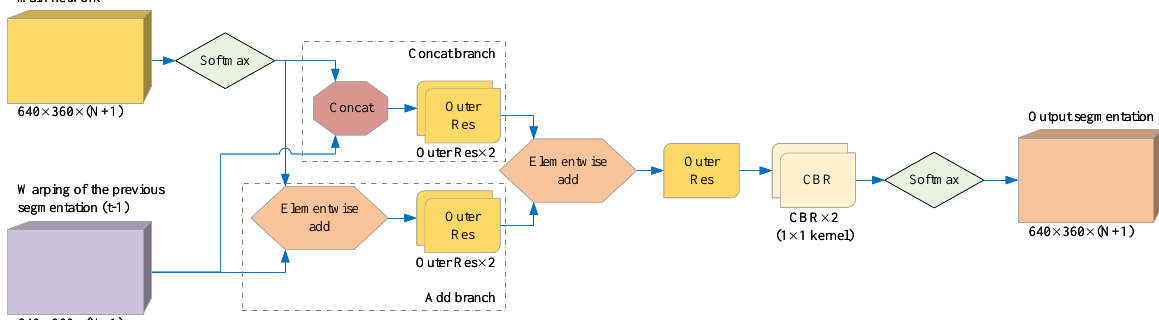
Figure 6. The structure of the optimized network. Our optimized network uses two feature map fusion methods to improve the main network segmentation results, so it contains two branches: a Concat branch and an Add branch. Finally, the optimized network outputs the segmentation results through